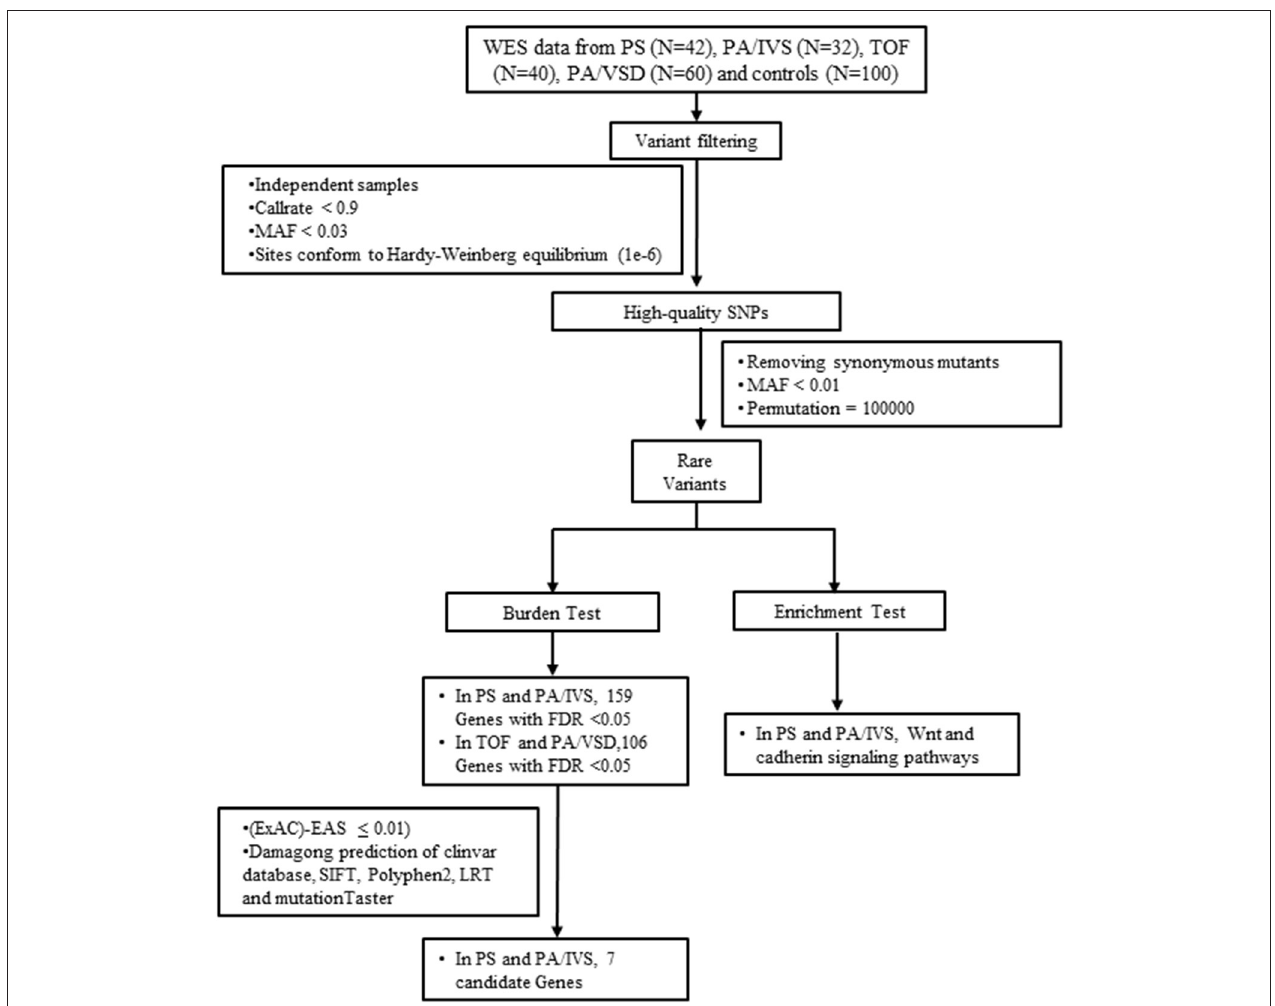
FIGURE 1 | The flow chart showed the different steps taken during whole-exome sequencing analysis. After variant calling, annotation and screening, variants were filtered by gene-based burden analysis. Candidate genes were collected by gene expression analysis. FDR, false discovery rate; MAF, minor allele frequency; PA/IVS, pulmonary atresia with intact ventricular septum; PA/VSD, pulmonary atresia with ventricular septal defect; PS, Pulmonary valvular stenosis; SNP, single nucleotide polymorphism; TOF, tetralogy of Fallot; WES, whole-exome